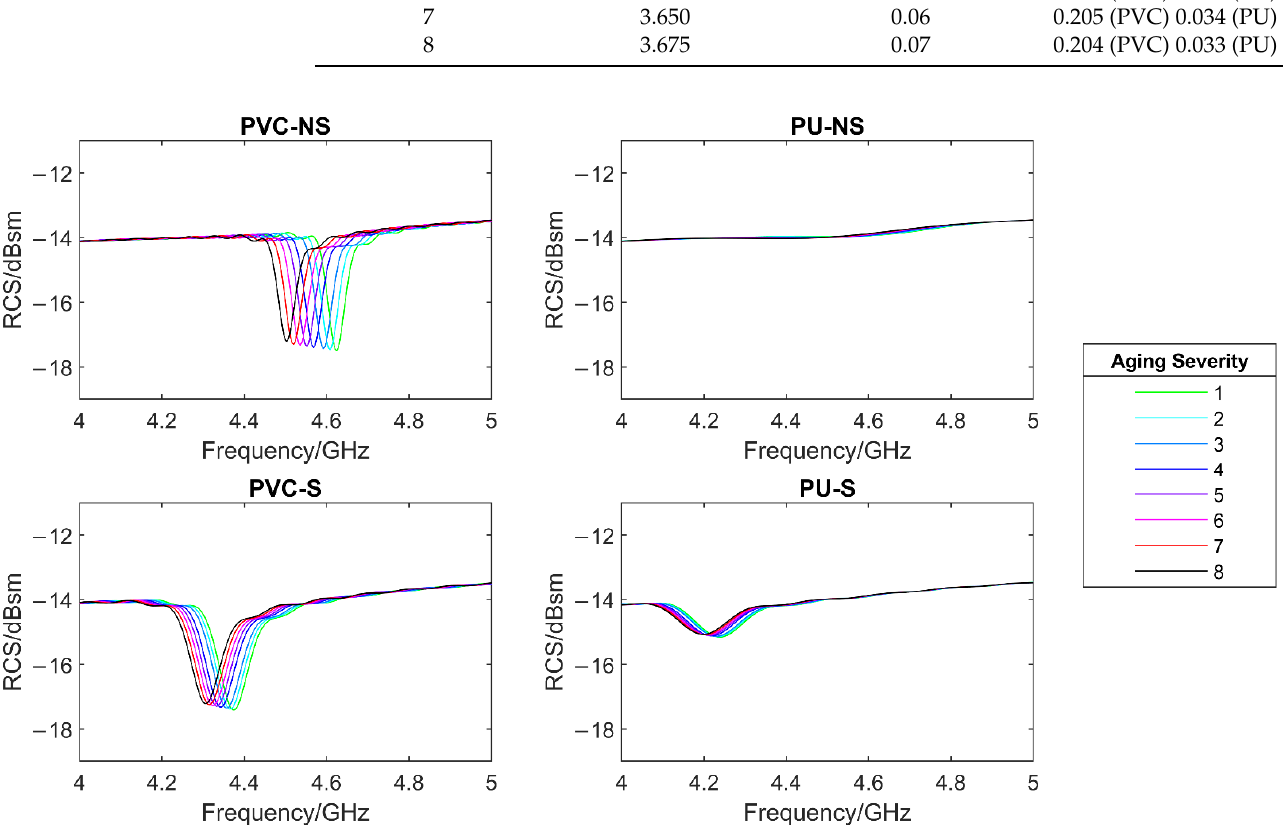
Figure 14. The effect of simulated aging on the simulated RCS response of each system.